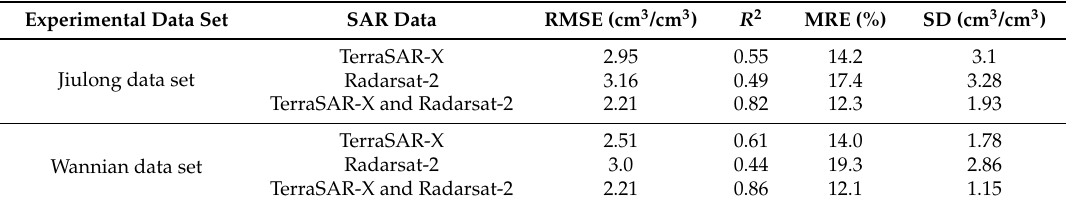
Table 2. Quantitative statistics between the measured and estimated soil moisture content using the SVR